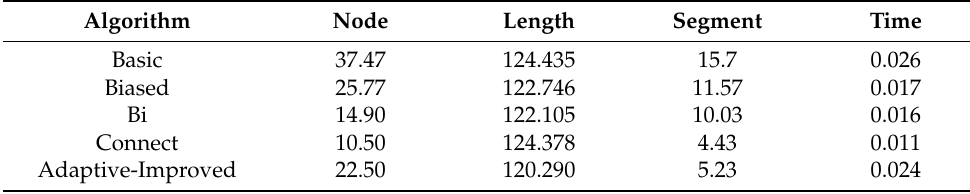
Table 3. Comparison of several RRT algorithms in the straight road environment: mean values in 30